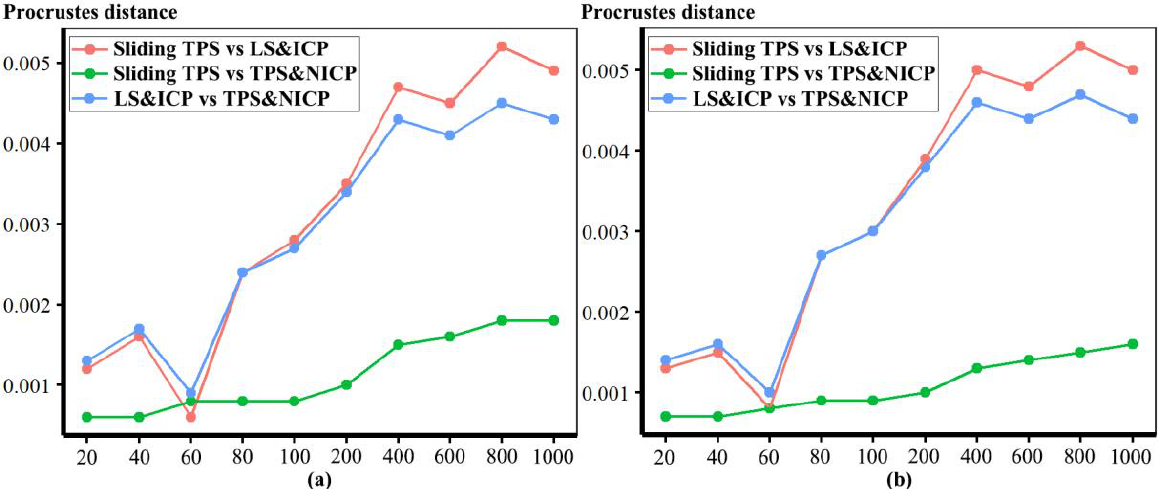
Figure 6. Procrustes distances computed between the mean surfaces of human heads obtained by different approaches after re-semilandmarking and re-warping the template mesh. ( a ) Procrustes distances computed between all the vertices ( b ) Procrustes distances between mean landmarks and semilandmarks.